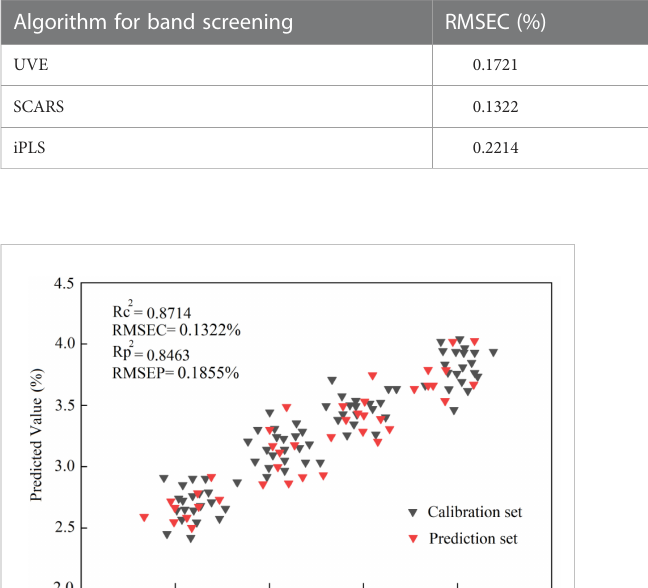
TABLE 3 The prediction results of the RBFNN model based on the THz spectrum. Algorithm for band